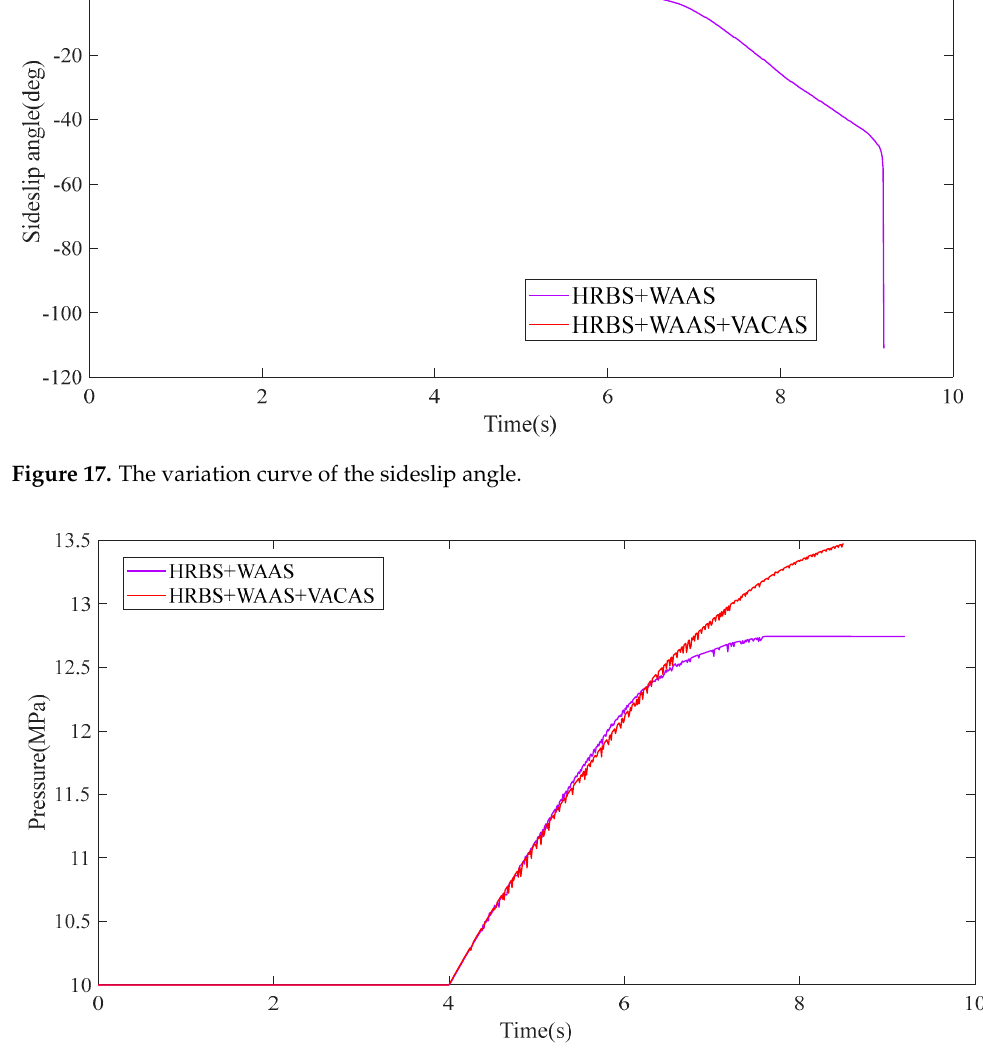
Figure 18. The variation curve of the accumulator pressure. Table 3. Comparison of the accumulator pressure.